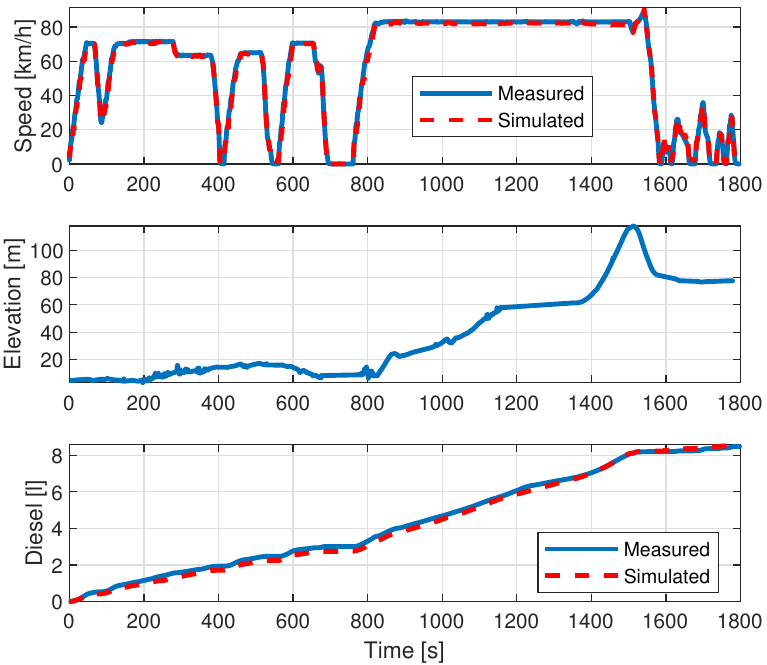
Figure 6. Comparison of the the baseline diesel heavy goods vehicle (HGV) model’s fuel consumption against experimental measurements for an in-service drive